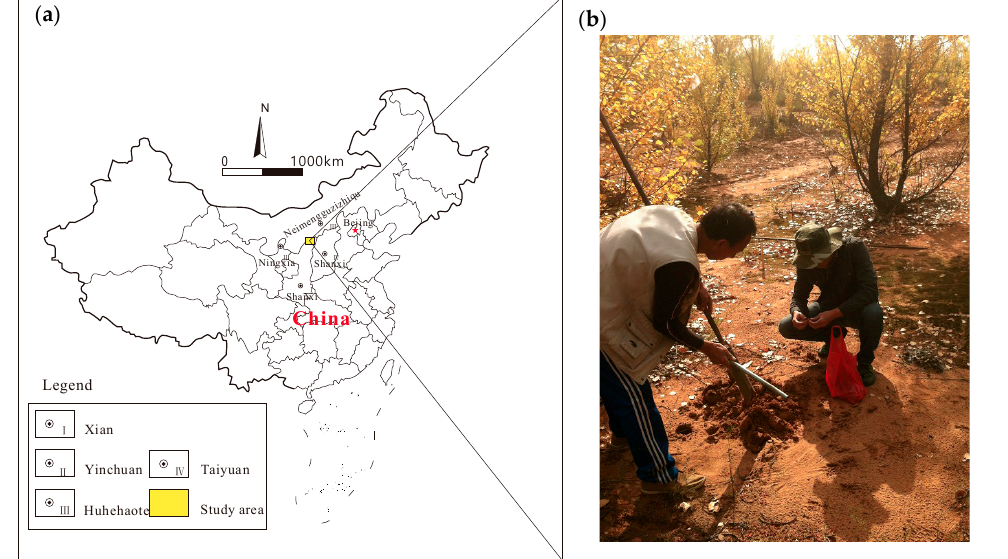
Figure 2. Location of the study area and surface characteristics. ( a ) location of the study area and ( b ) surface characteristics of the study area.